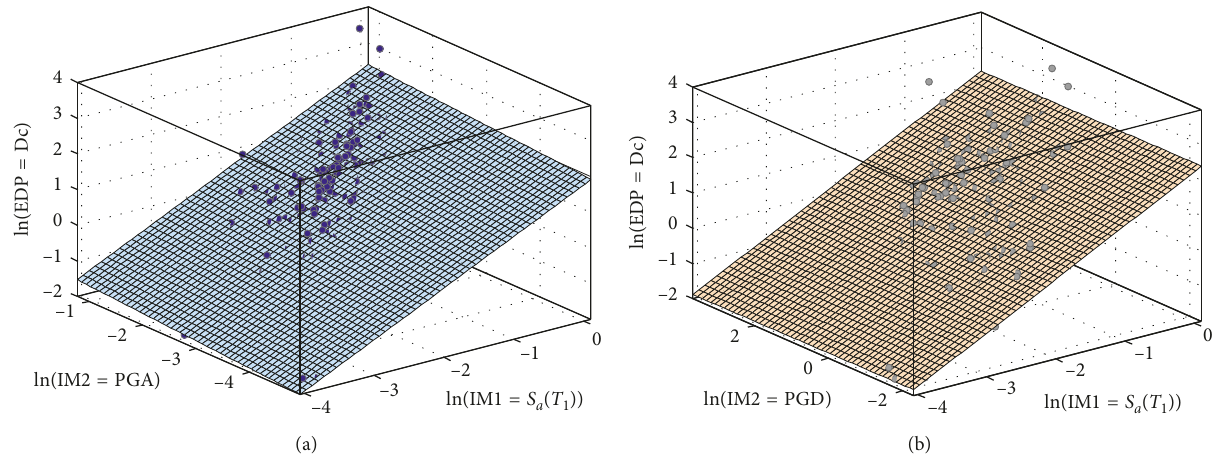
Figure 6: Estimates of mean of ln( Δ (a) IM 2 � PGA and (b) IM 2 � PGD. Table 4: Dispersion of EDP | IM angles show the dispersion values for the EDP as Δ c and E D , respectively.